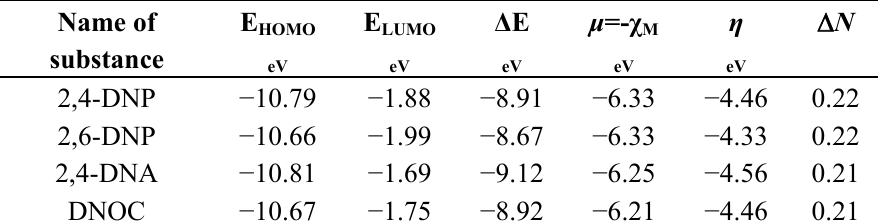
Table 6. Energy data calculated theoretically